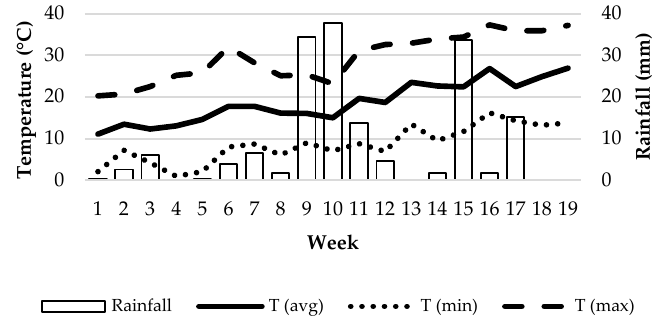
Figure 3. Weekly temperatures and rainfall during the experimental period.